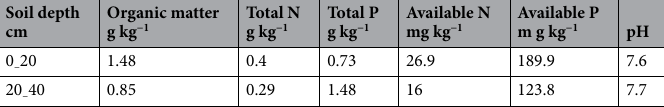
Table 2. Soil chemical properties in the pots before the begging of